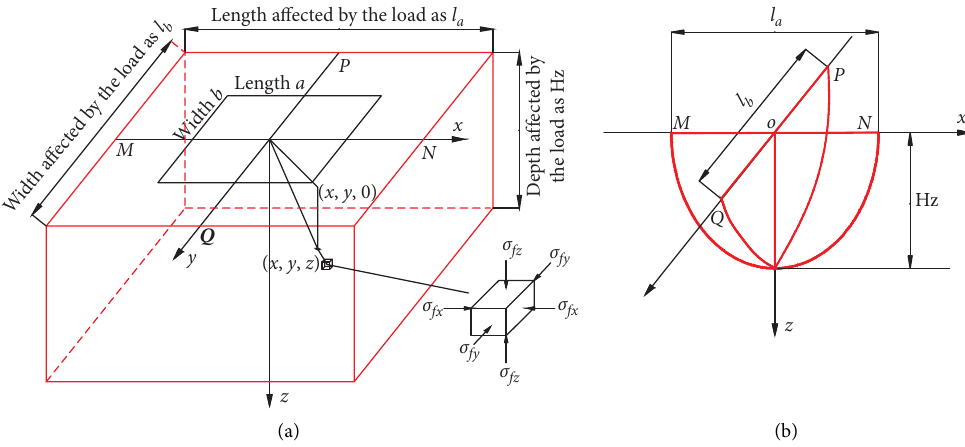
Figure 14: (a) Spatially influenced range of the foundation soil; (b) spatial relationship between l